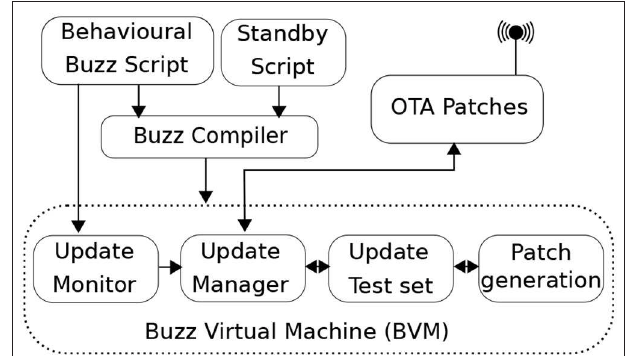
FIGURE 4 | Update monitor within the Buzz Virtual